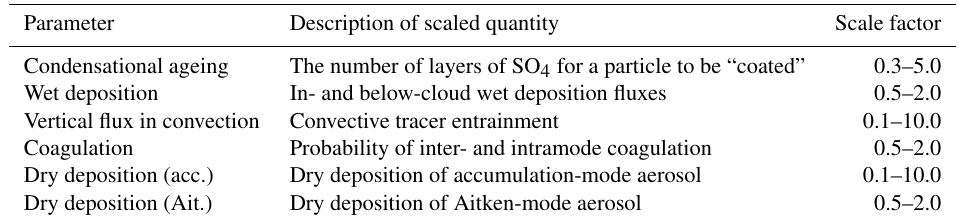
Figure 1. Spatial coverage of flight campaigns included in the GASSP database which include number size distribution or CCN measure- ments. Table 2. Outline of the sensitivity experiments performed. The scale factors refer to the high and low multiplicative factors applied to the relevant model parameter. See text for